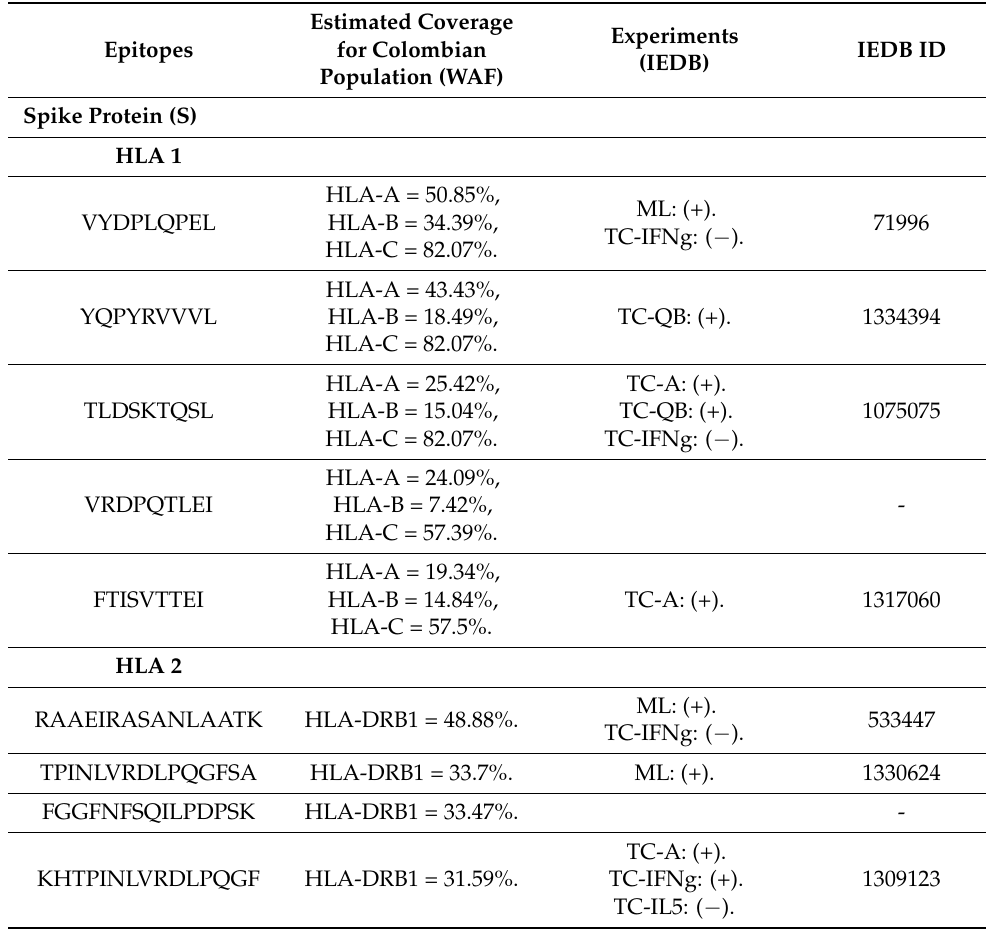
Table 9. Promising peptides for epitope-based vaccine design from structural proteins of SARS-CoV-2 showing the estimated coverage and the availability of experiments in the immune epitope database (IEDB). These molecules presented predicted immunogenicity, non-toxicity and non-allergenicity. (IEDB, date consulted: 31 March 2021). Abbreviations: ML: MHC ligands assays. TC-IFNg: